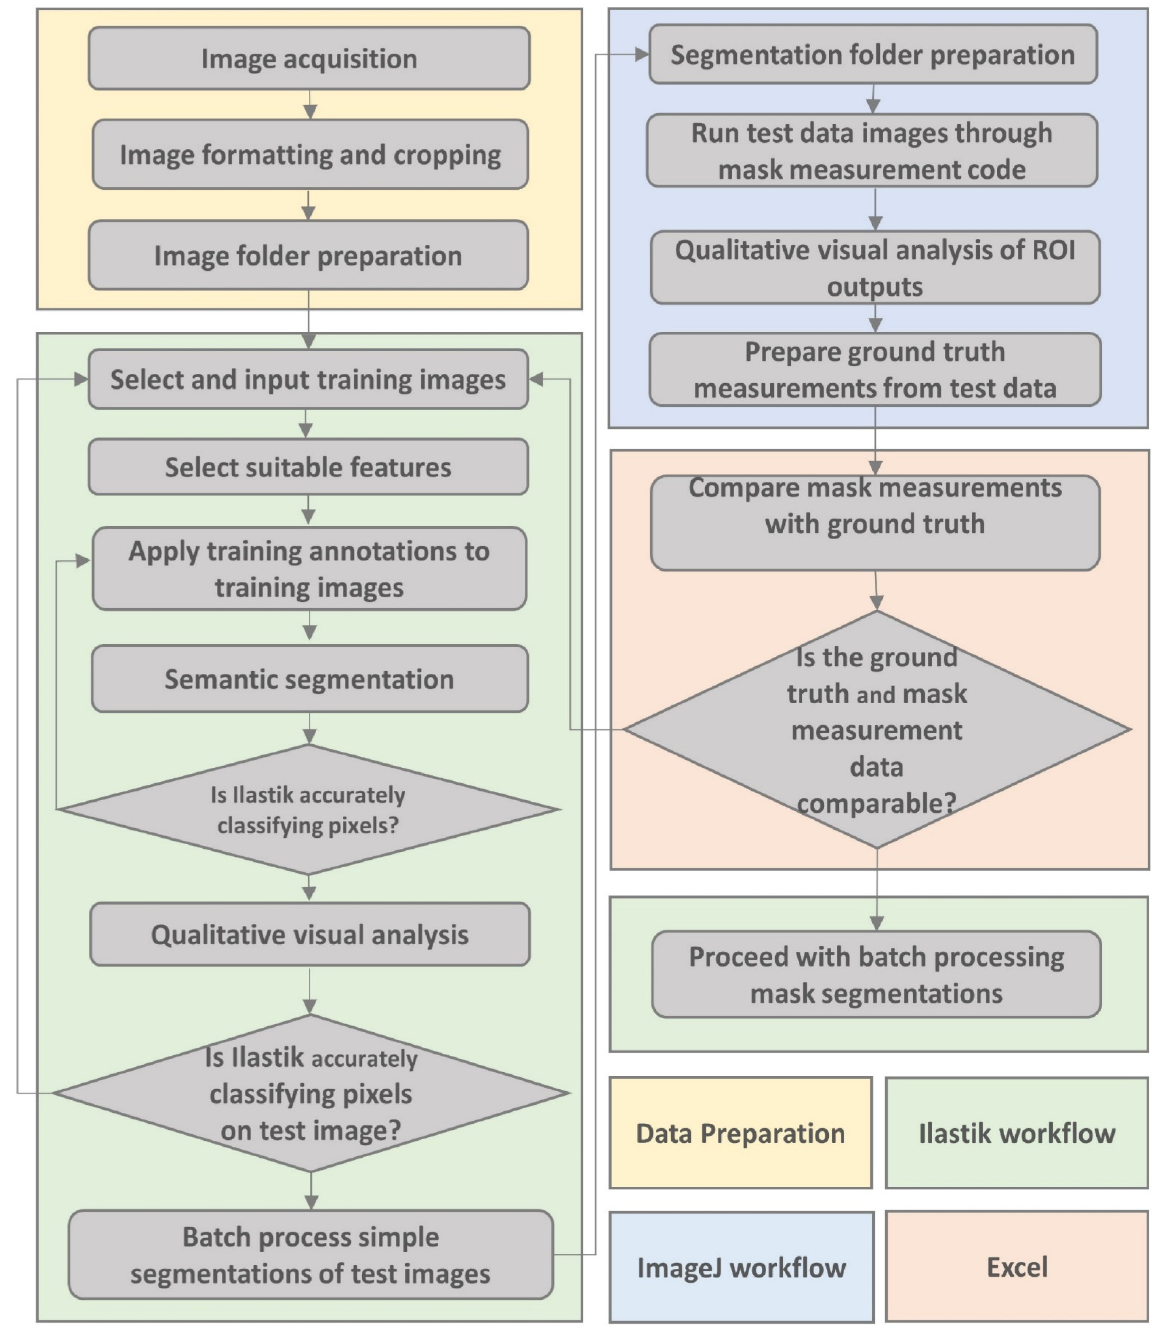
Figure 1. Overview of the coral juvenile machine learning image anaylysis pipeline. The pipeline is divided into four sections as outlined in the bottom right-hand corner of the figure: data preparation (yellow), Ilastik workflow (green), Fiji ImageJ workflow (blue), and Excel workflow (red).